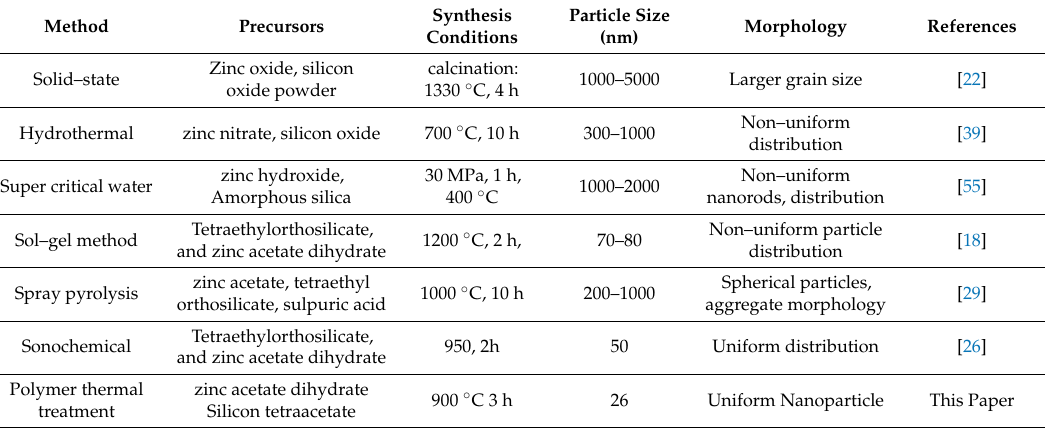
Table 4. Characterization comparison of the produced willemite NPs obtained other similar